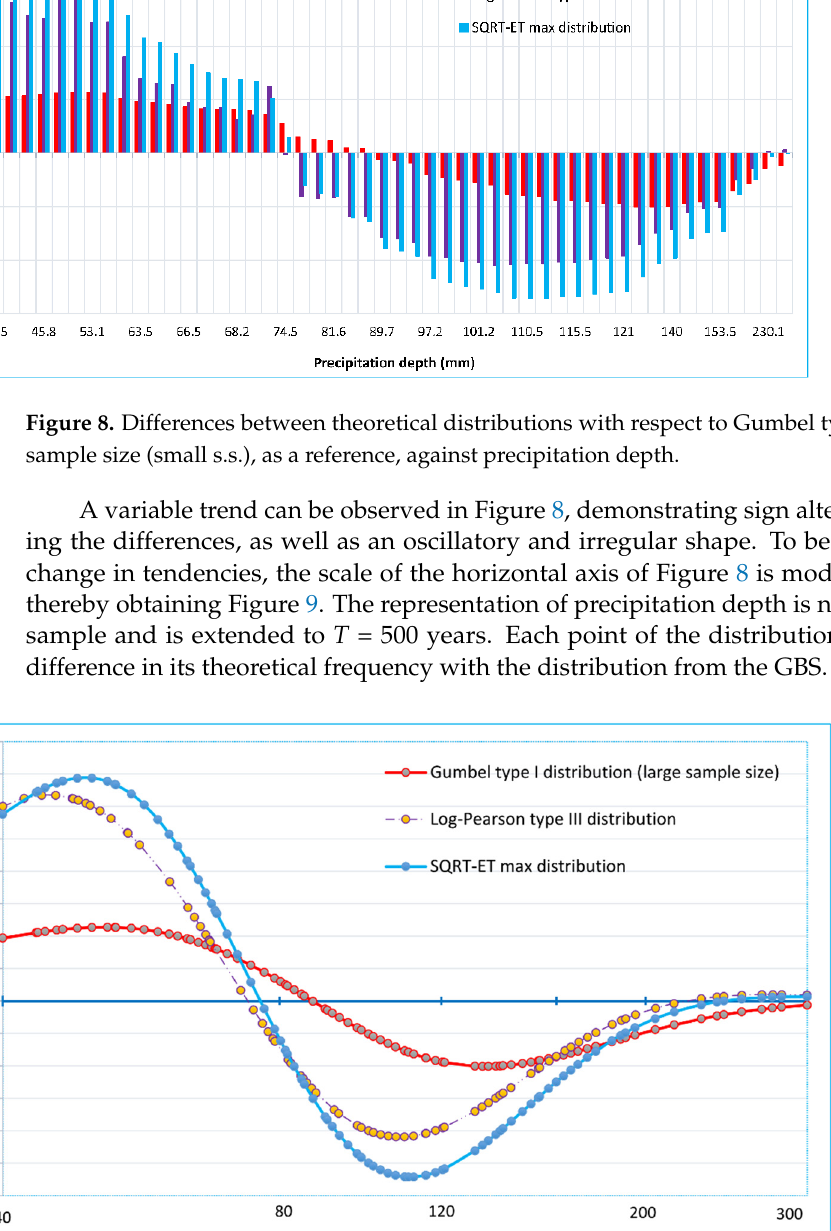
Figure 7. Differences between theoretical and sample distributions (absolute value) against precip- itation depth.